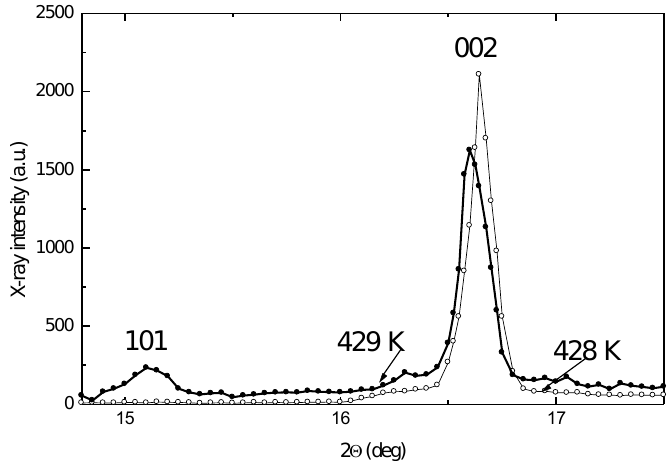
Figure 4. ( a ) The diffraction pattern of In (set A) collected during melting (black dots) is the sum of liquid (open circles) and solid (continuous line) contributions. ( b ) The RDF curve, 4π r 2 ρ( r ) vs. r , obtained from the diffraction pattern after the completion of S-L transformation. Bars indicate the distribution of 1st and 2nd neighbors in crystalline In. Samples of set B exhibit the same behavior: XRD spectrum shows only the {101} reflection up to 428 K and the {200} peak appears at 429 K.